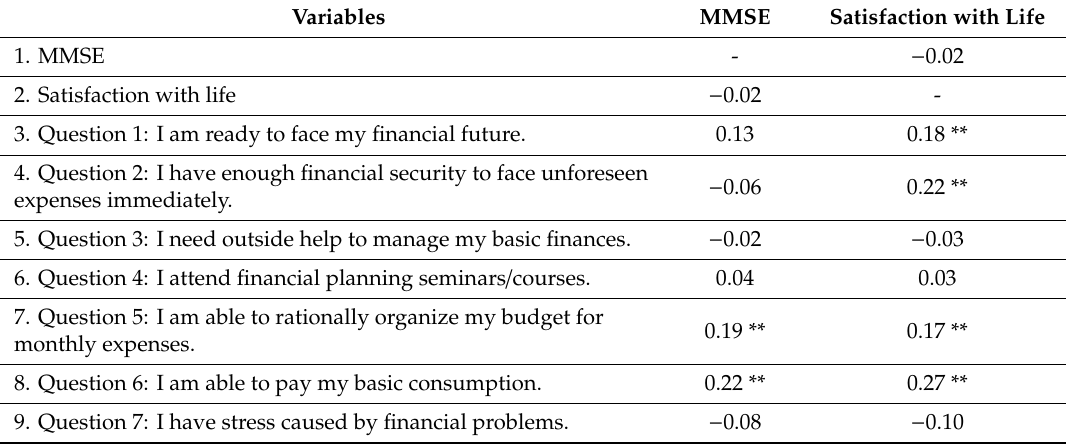
Table 3. Correlation matrix between Mini-Mental State Examination (MMSE) and life satisfaction with the financial attitude